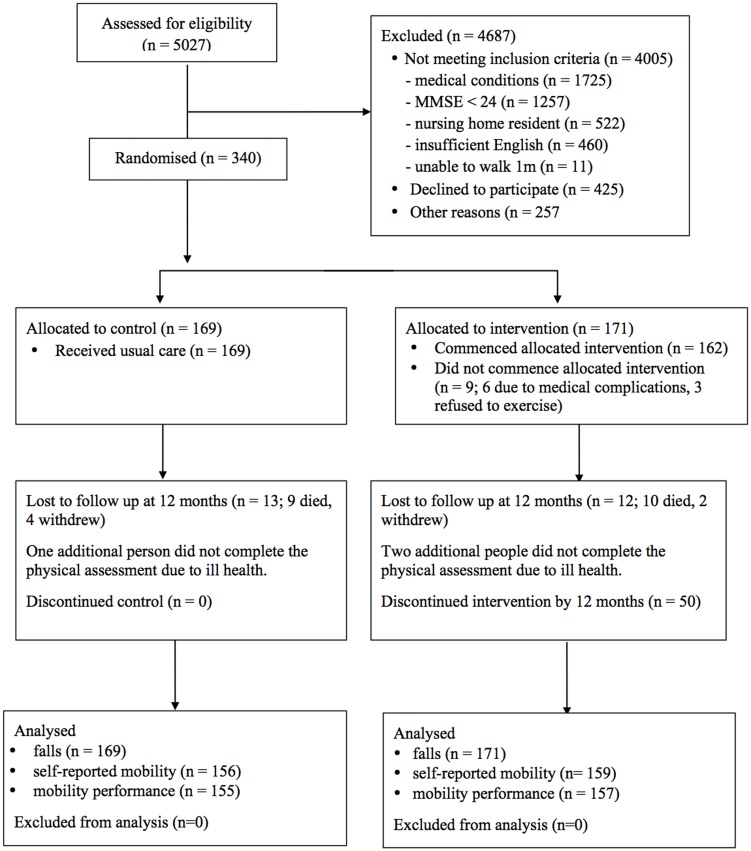
Participant flow.